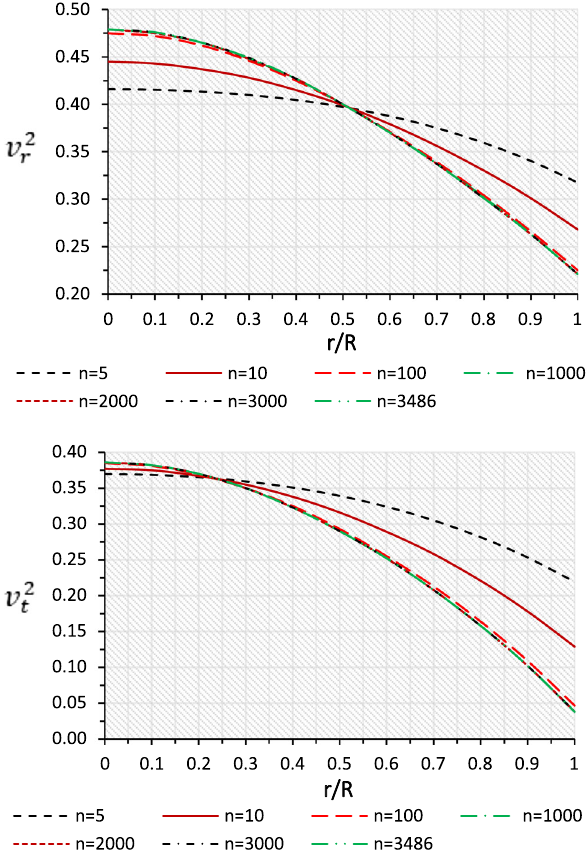
Fig. 4 Behaviour of energy density ρ( r ) (top) and pressure anisotropy Δ (bottom) vs. radial coordinate r / R with different values of n for LMC X − 4